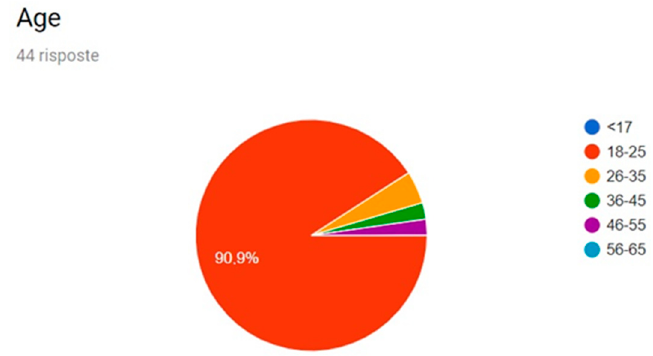
Figure 5. Customer age.